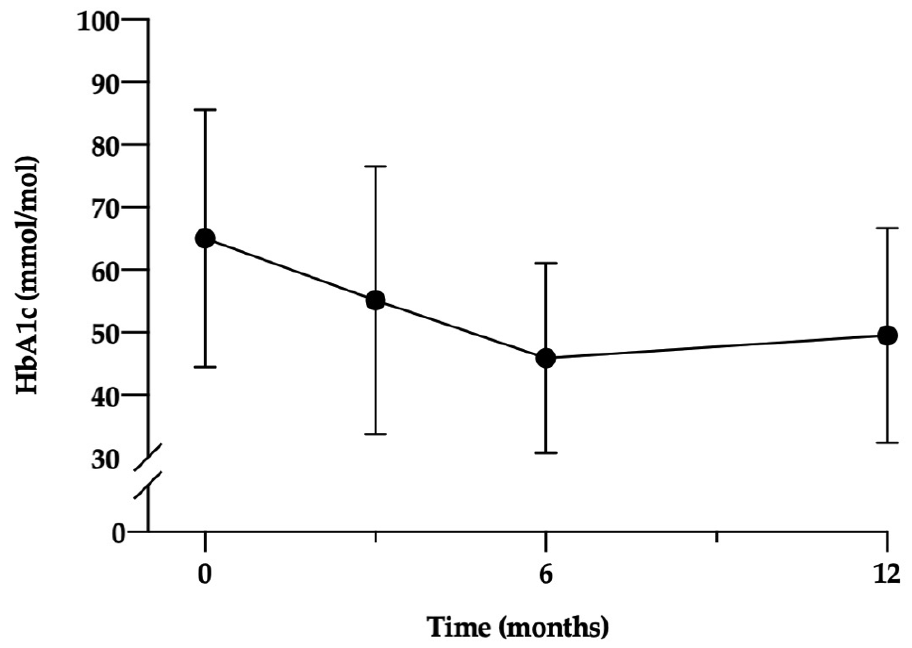
Figure 2. HbA1c outcome of participants over 12 months. HbA1c, glycated heamoglobin. Binomial logistic regression was conducted to assess the predictors of T2DM remission, while individually, both weight loss at 3 and 12 months predicted participants achieving respectively). When controlling for other variables, no factors increased the likelihood of T2DM